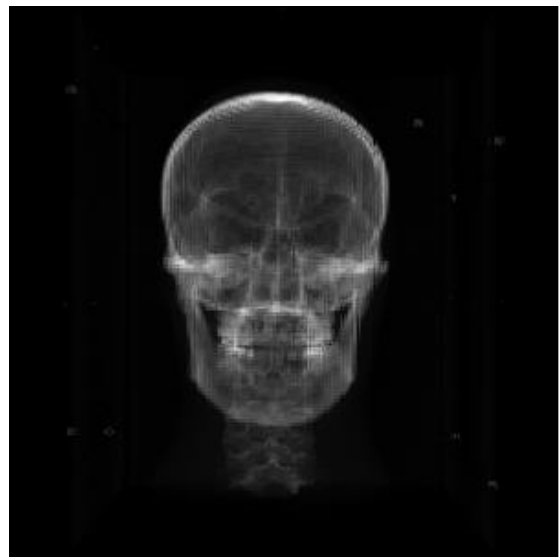
Figure 3. DRR image at the initial value.